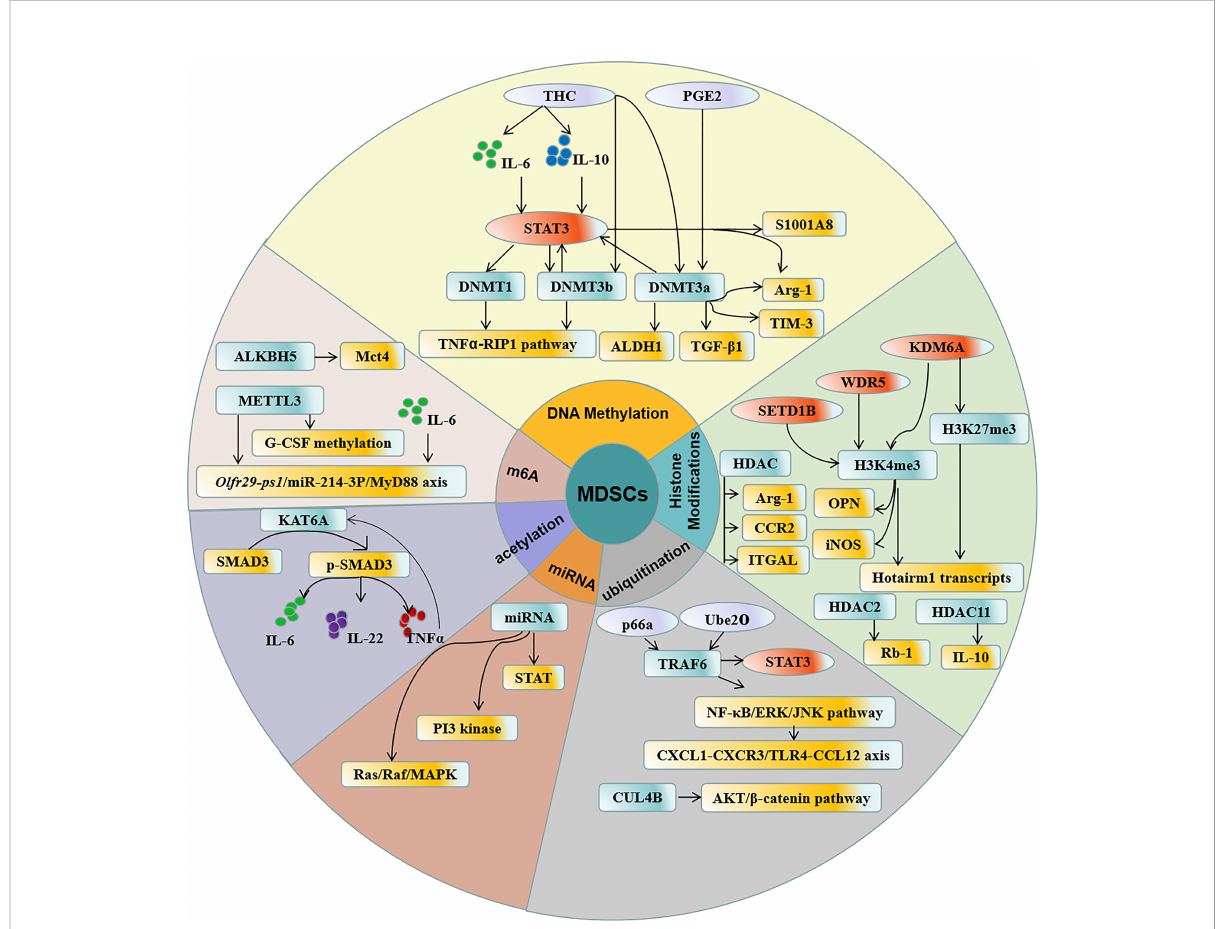
FIGURE 1 Regulation of epigenetic modi fi cation in MDSCs. DNA methylation, Histone acetylation, N6 -methylation, ubiquitination, acetylation, and miRNA participate in the epigenetic modi fi cation in MDSCs which contribute to the accumulation and function of